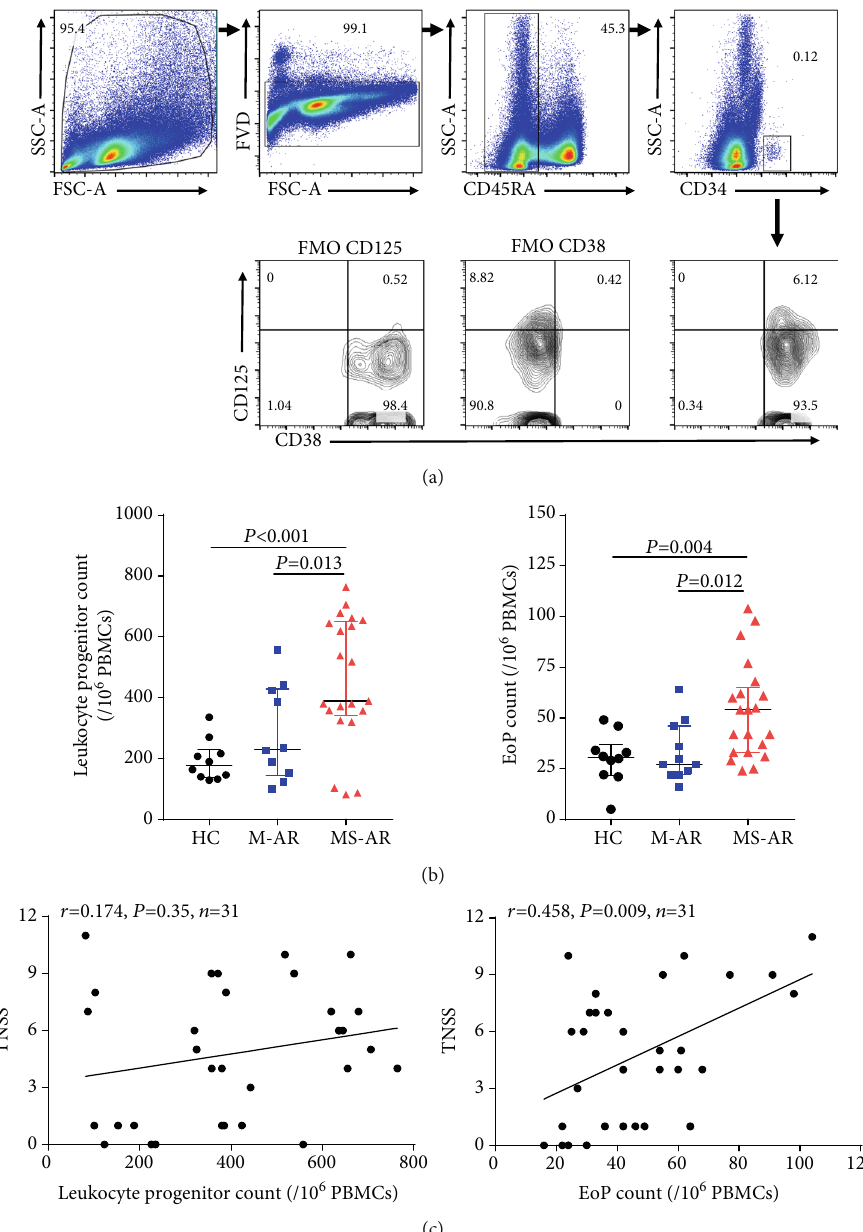
Figure 4: Levels of eosinophil progenitors in the peripheral blood are increased in patients with moderate-severe allergic rhinitis. (a) Gating strategy for of leukocyte progenitors (live CD45RA-CD34 + cells) and eosinophil progenitors (live CD45RA-CD34 + CD125 + CD38 + cells) in the peripheral blood. (b) Levels of leukocyte progenitors and eosinophil progenitors in the peripheral blood of healthy controls, mild allergic rhinitis, and moderate-severe allergic rhinitis. Progenitor levels are expressed in absolute numbers per one million PBMCs. (b) Correlation of leukocyte progenitor and eosinophil progenitor absolute numbers in patients with allergic rhinitis in the peripheral blood with TNSS. HC: healthy controls; M-AR: mild allergic rhinitis; MS-AR: moderate-severe allergic rhinitis; PBMCs: peripheral blood mononuclear cells; FMO: fl uorescence minus one control; EoP: eosinophil